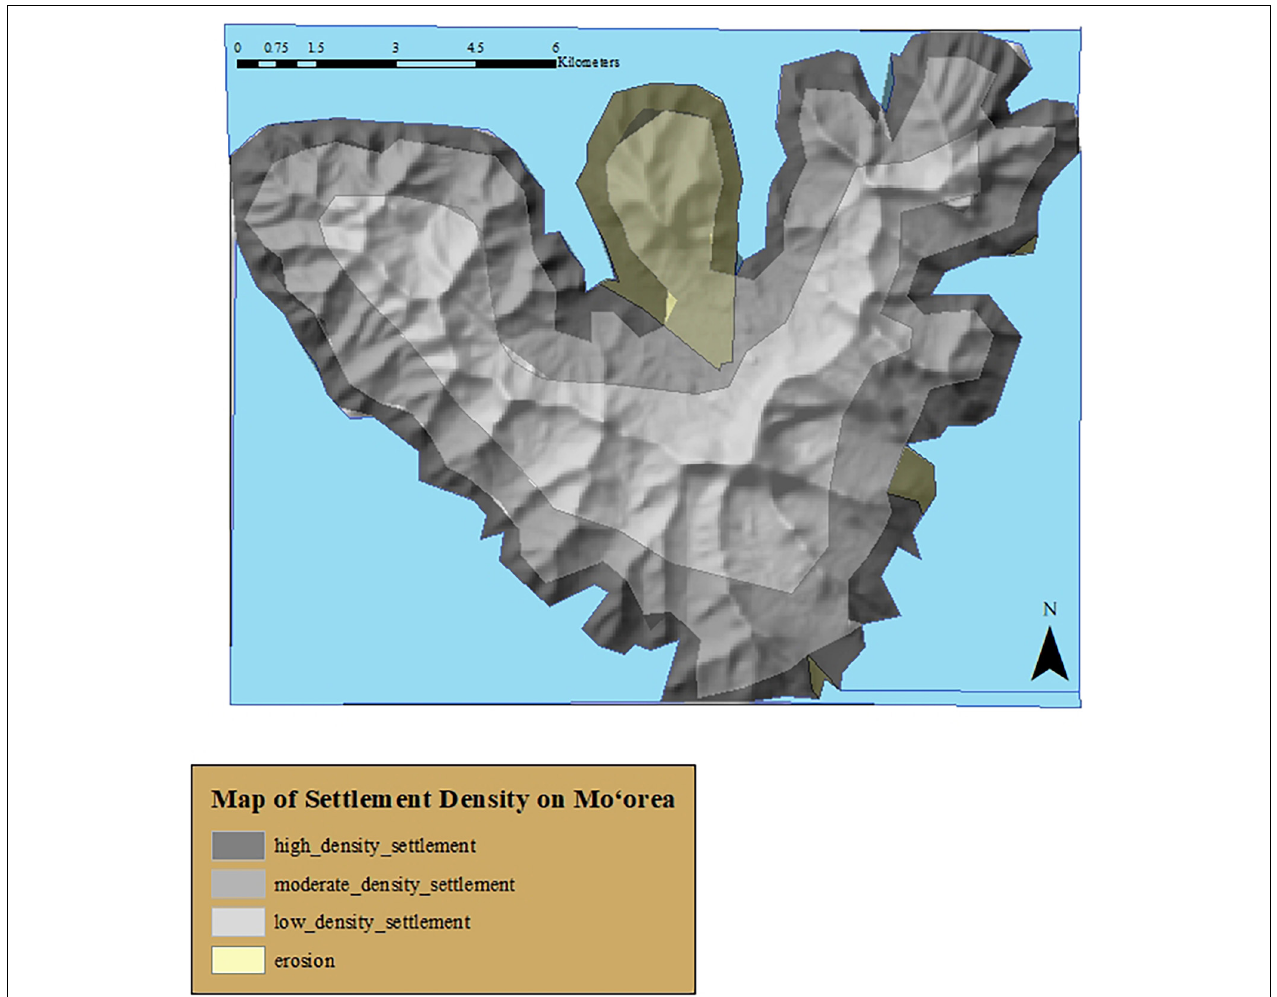
FIGURE 5 | Visualization of archaeological site densities and elevation for the Island of Mo‘orea.